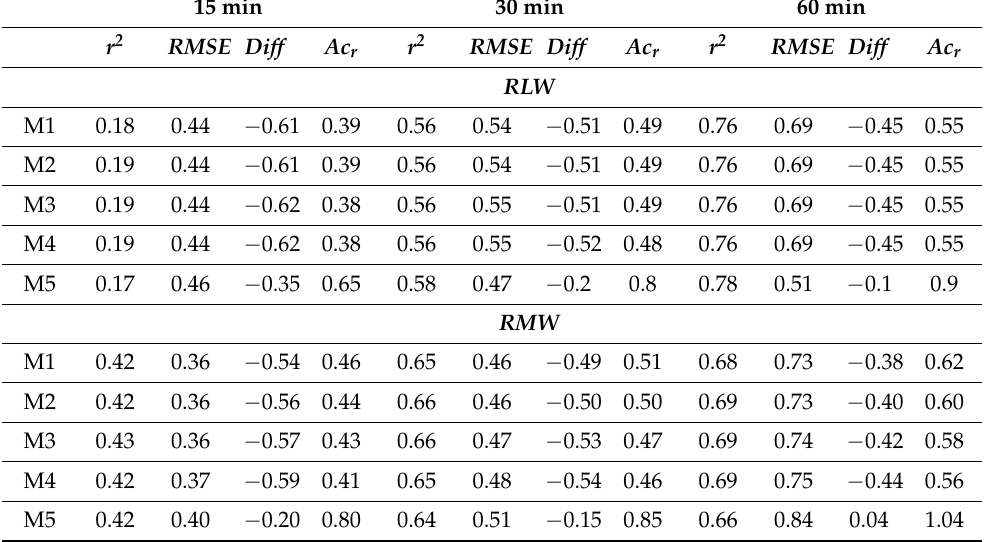
Table 8. Coefficient of correlation ( r 2 ), RMSE , relative difference ( Diff ) and accumulated ratio ( Ac r ) between corrected precipitation following the five density models and TPB precipitation for 15, 30, and 60 min timescales. Scores are displayed for low ( RLW ), moderate ( RMW ), and high wind speed ( RHW ) groups and for all liquid precipitation records.